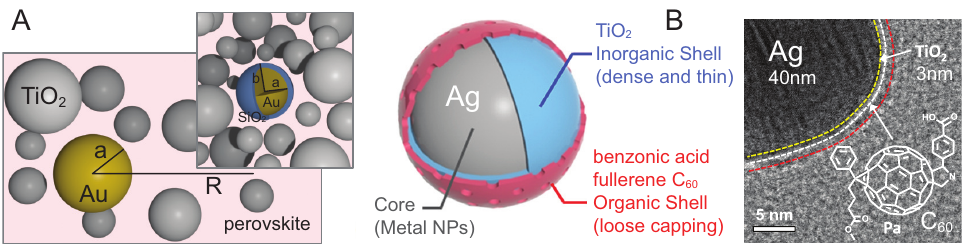
Figure 3. ( A ). Spherical Au nanoparticles (with the radius a ) are capable of being embedded in the perovskite layer due to the crystallization of this layer using liquid precursors with an admixture of metallic nanoparticles. Conveniently, nanoparticles of gold can be located close to porous basis of TiO 2 or (Al 2 O 3 ) of the electron transport layer. The density of particles is low, of the order of 1 wt% with respect to the porous basis of TiO 2 (as in the experiments reported in [14]). Such a low concentration of Au nanoparticles does not disturb the morphology of the cell layers. Moreover, they are additionally coated with a dielectric layer of SiO 2 up to a final radius of b 48 nm (bare nanoparticles have a radius of a 40 nm) in order to reduce contact with the naked metal and related structural distortions. ( B ). Multi-shell plasmonic particle Ag@TiO 2 @organic-shell (left) and its HRTEM image (right). The organic outer-coating layer with the chemical structure depicted in the right picture is applied to reduce the aggregation of plasmonic particles. Such multi-shell Ag particles were used in the experiments reported in [15] in an inverted-architecture perovskite cell with a hole–absorber PIDTT layer to which the organic coating of Ag multi-shell particles was matched.